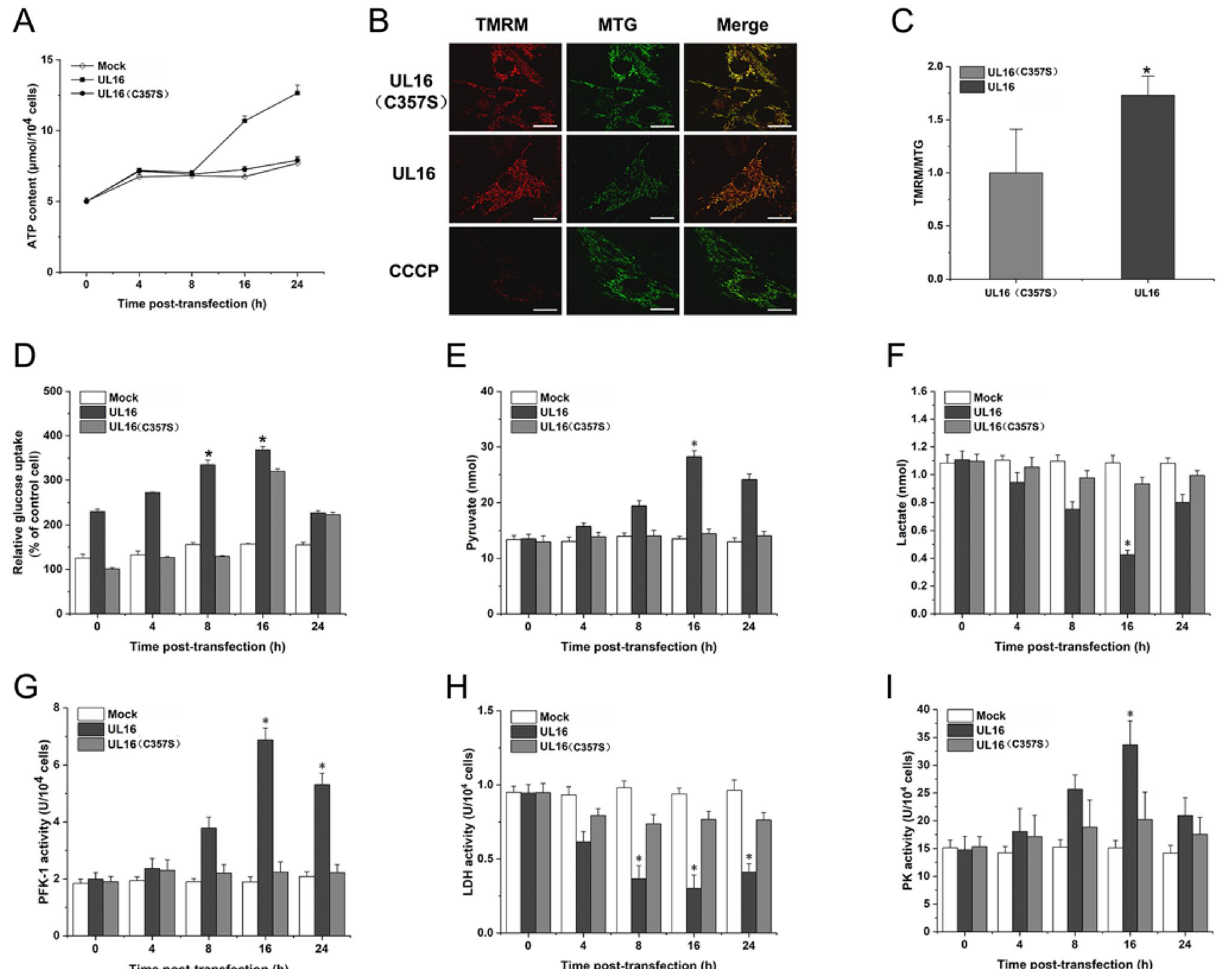
Figure 3. Test for aerobic oxidation in HUVEC after UL16 transfection. ( A ) HUVEC cells was transfected with UL16, UL16 (C357S) and MOCK (empty plasmid), respectively. After transfection, HUVEC cells transfected with or without virus protein at moi0.5 were cultured for 24 h and then subjected to the measurement of ATP content. ( B , C ) Comparison of MMP between mock cells (upper) and UL16 transfected cells (lower). Data are the means ± SD of values from three fields containing more than 100 cells (bar.10 μm, * p < 0.05, ** p < 0.01). ( D ) HUVEC cells were transfected with UL16, UL16 (C357S), mock (empty plasmid). At different times post-transfection, the supernatants were collected, and glucose consumption was measured. ( E and F ) The concentrations of pyruvate, and lactate were measured at different time points after transfected. ( G , H and I ) The monolayers from mock-, UL16 and UL16 (C357S) transfected HUVEC cells were cultured for 24 h and then PFK-1, LDH and PK activity were measured. These enzyme activities were measured by the corresponding enzyme activity detection kit at different time points after transfected. Each value represents the mean of triplicates and barsindicate standard deviation. *Represents a p value below 0.05, **represents a p value below 0.01 for comparisons between mock- and UL16, UL16 (C357S) transfected